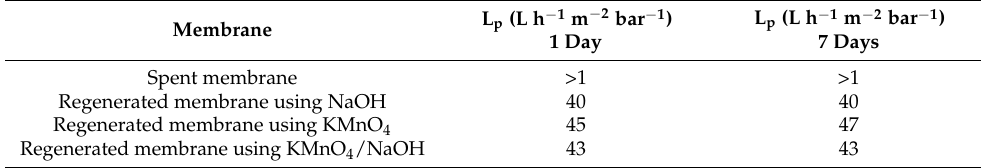
Table 3. Permeability of spent and regenerated